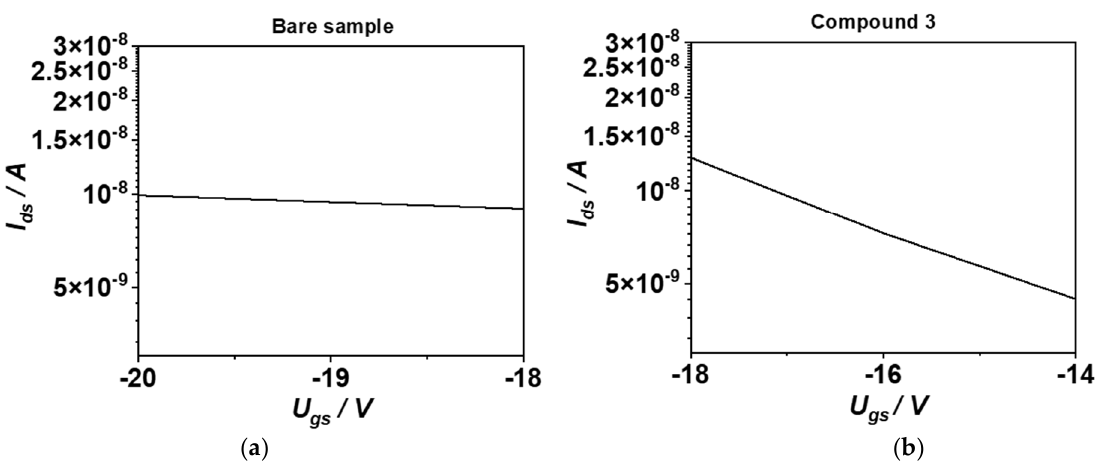
Figure 8. Subthreshold regime of transfer curves for transistors on silicon dioxide without a BQMI layer ( a ) and coated with compound 3 ( b ).